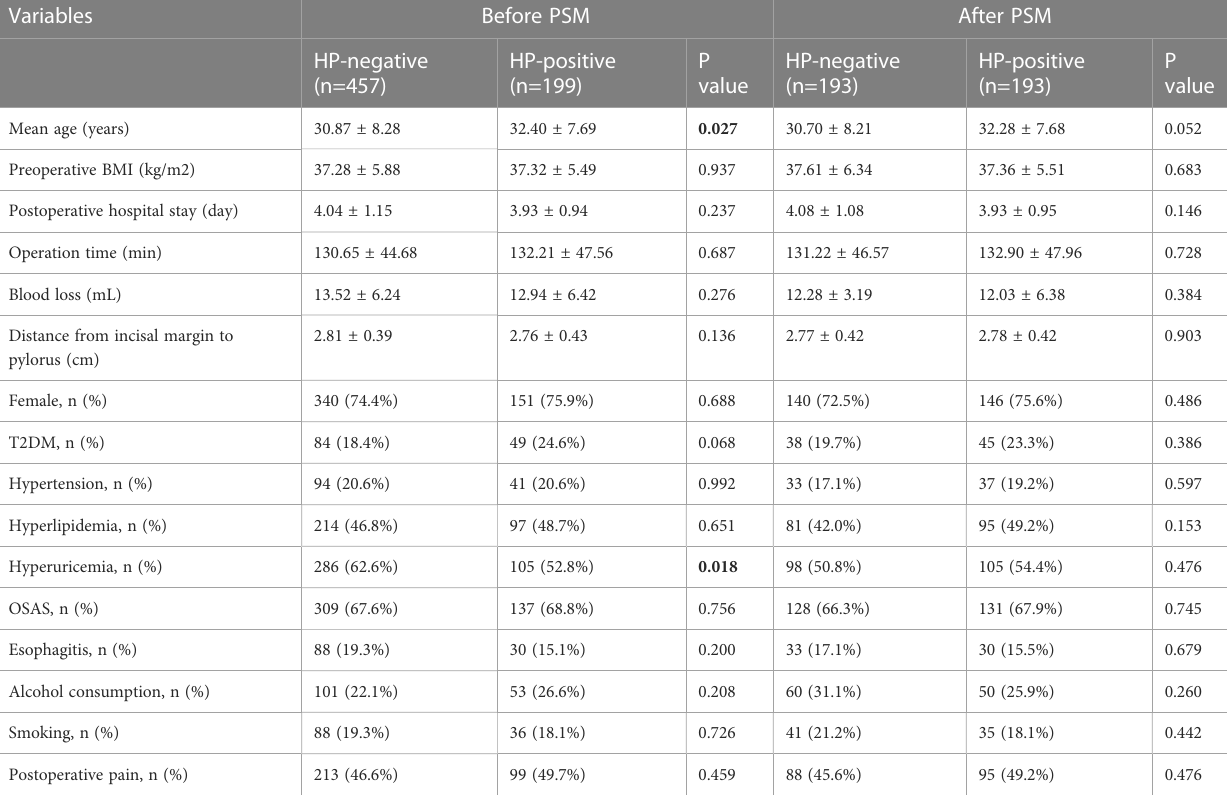
TABLE 1 Demographical characteristics and clinical data of the patients (before and after PSM). Variables